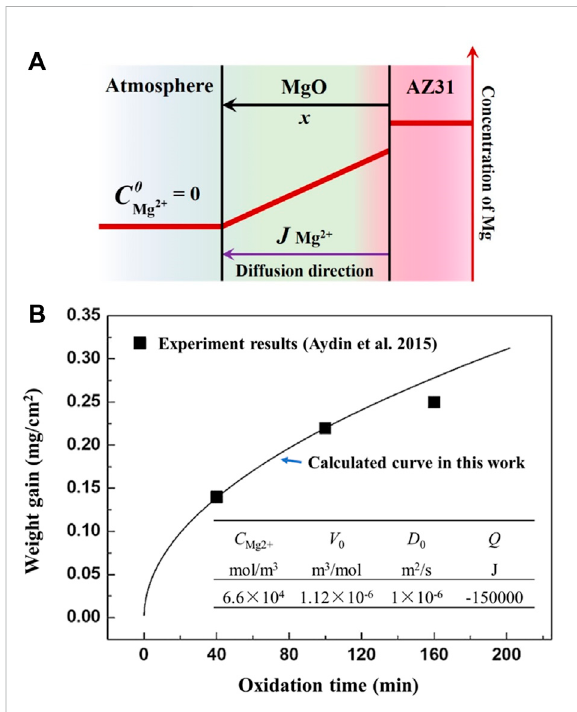
FIGURE 5 Illustrationoftheoxide growth modeland thecorresponding calculation result. (A) The kinetics calculation model used in this study (B) the calculated result of oxide growth on magnesium at 773